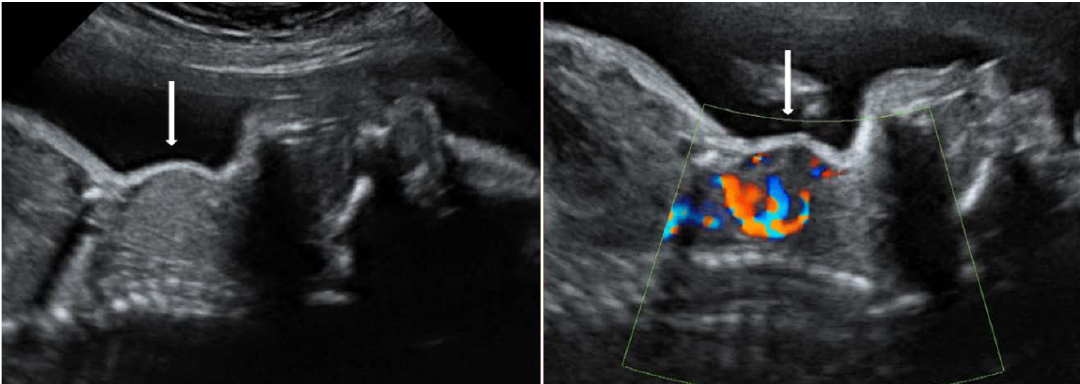
Figure 3. Fetal thyroid goiter (arrow) in gray-scale and power Doppler (courtesy of the Fetal Medicine Foundation).